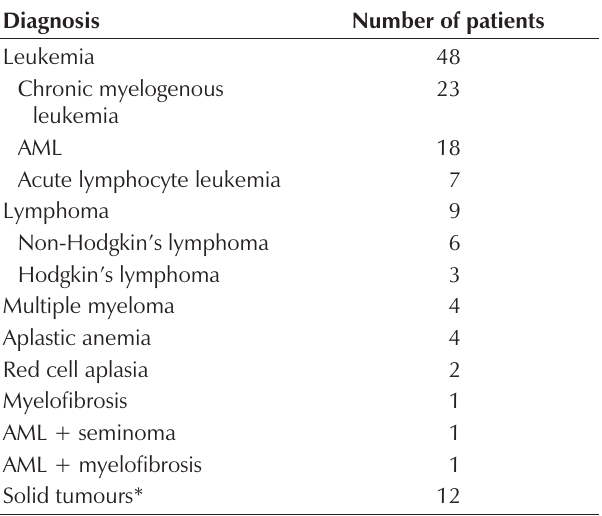
Underlying malignancies in patients undergoing broncho- scopy with bronchoalveolar lavage Diagnosis Number of